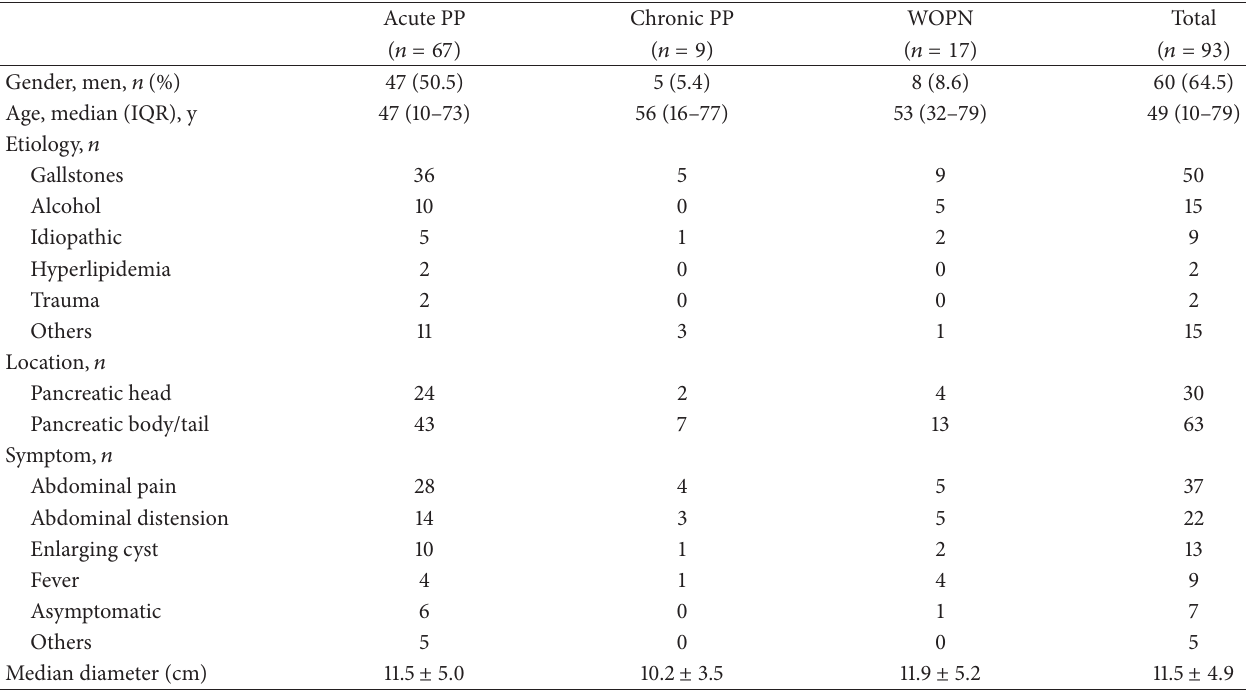
Table 1: Characteristics of patients with pancreatic fluid